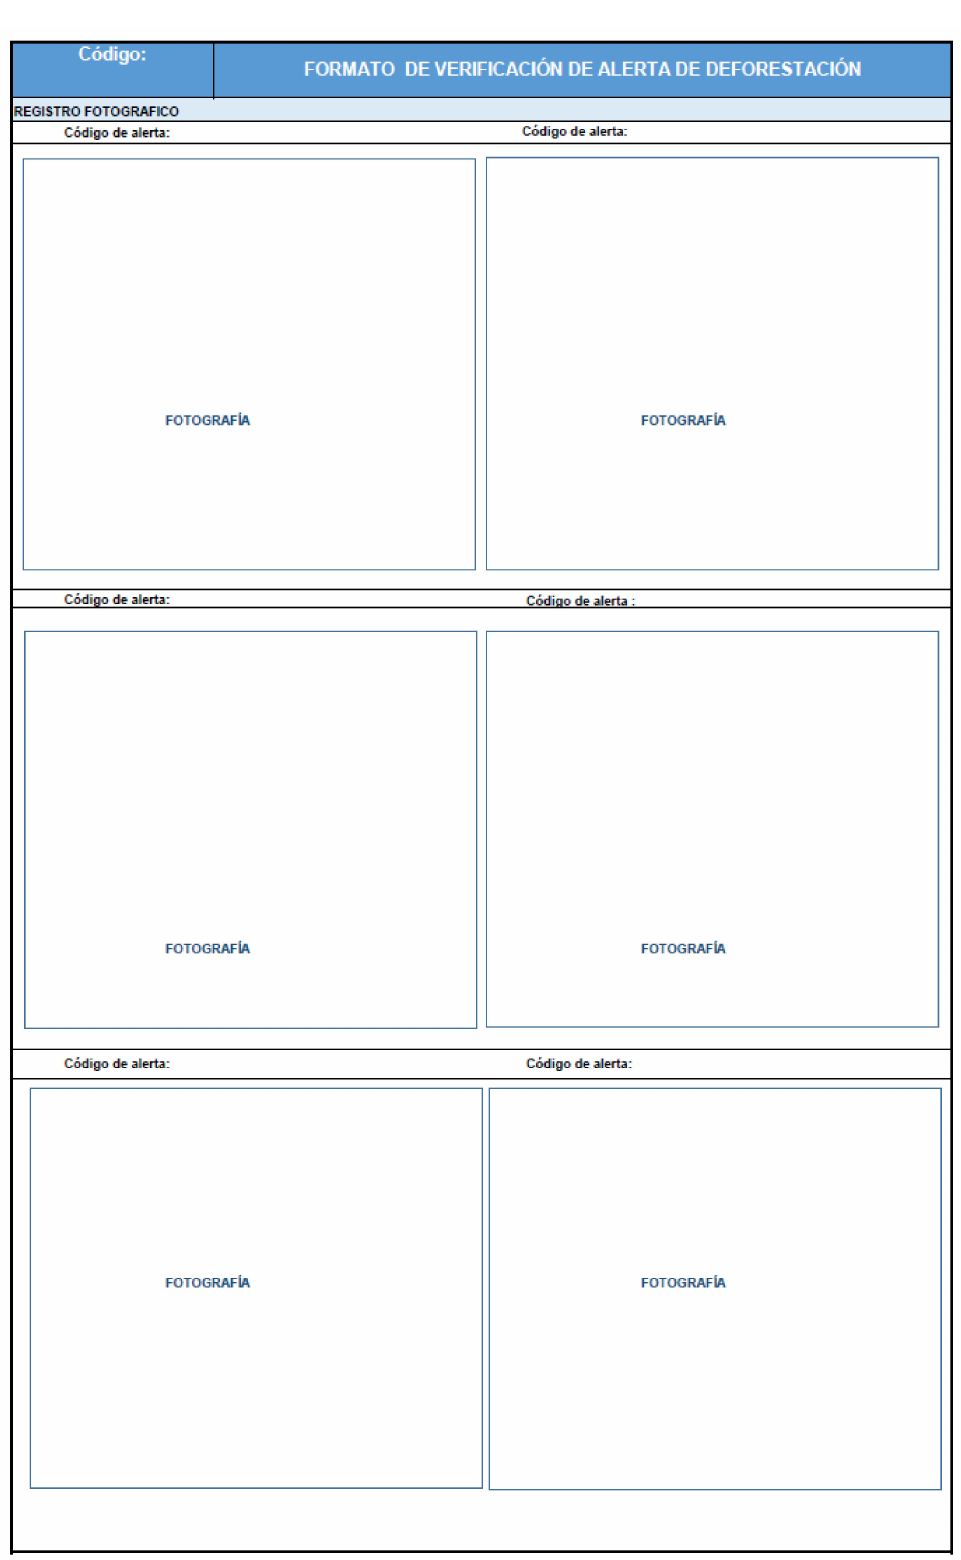
Figure A1. Deforestation alert verification